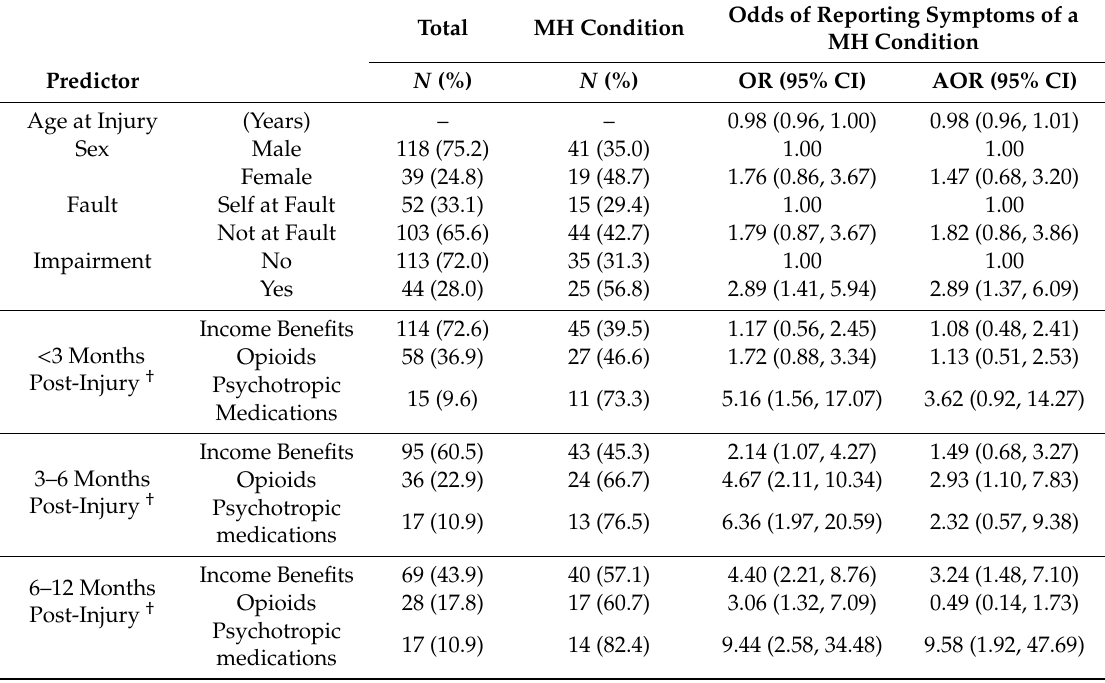
Table 5. Binary Logistic Multivariable Regression Coe ffi cients of Early Prognostic Factors for Symptoms of a Mental Health Condition after Compensable